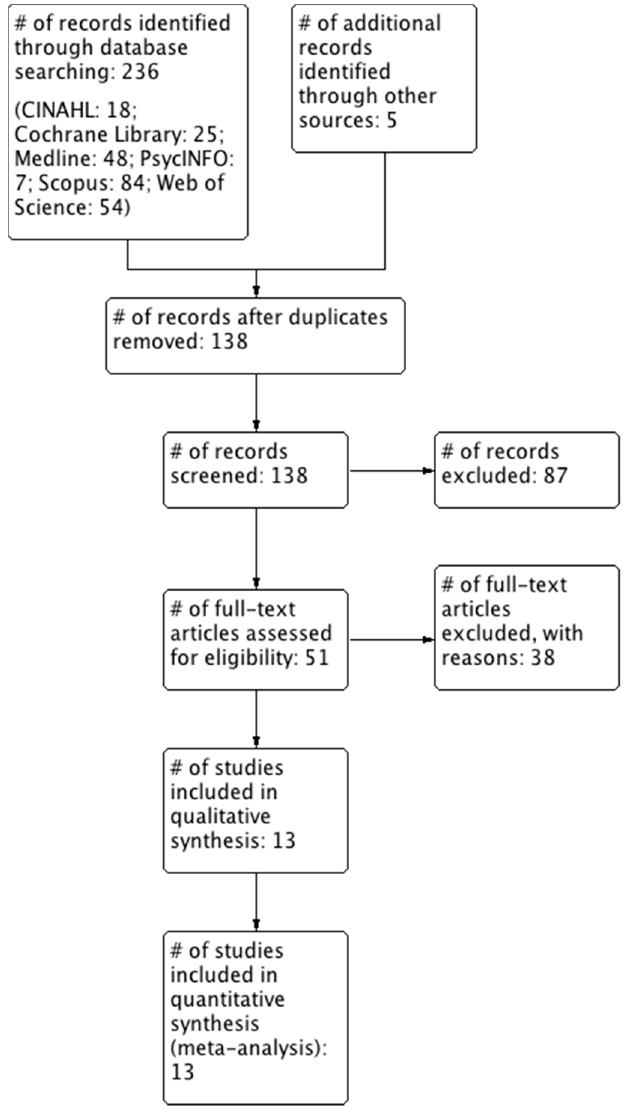
Figure 1. Flow diagram of study selection. #, number.